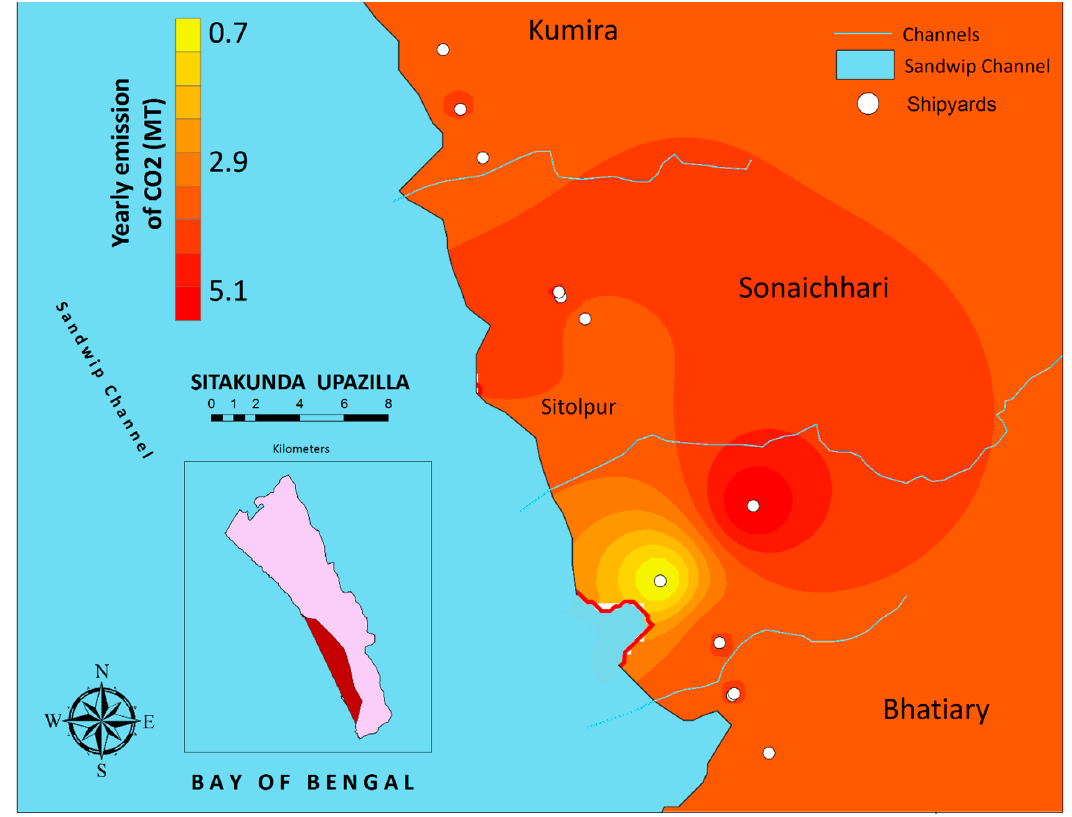
Figure 3. Spatial distribution of yearly CO 2 emission (metric tons (MT)) throughout the shipyards.